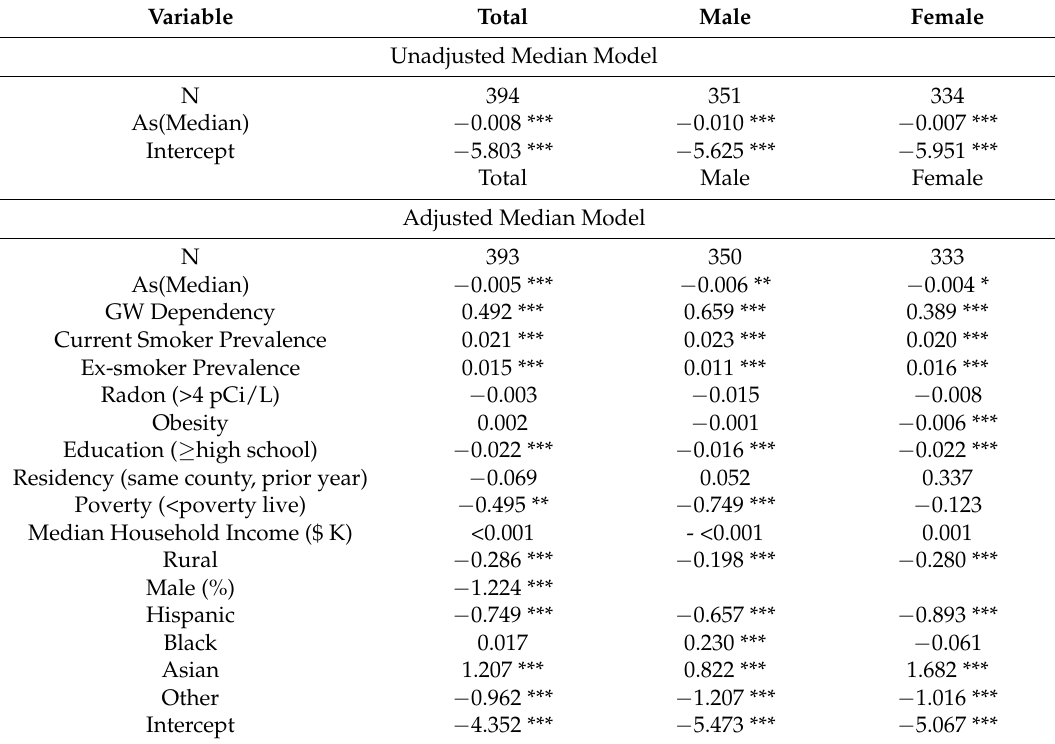
Table 3. Unadjusted and adjusted Poisson log-linear models for lung cancer incidence restricted to US counties with high dependency ( ≥ 80%) and low maximum arsenic exposure ( ≤ 50